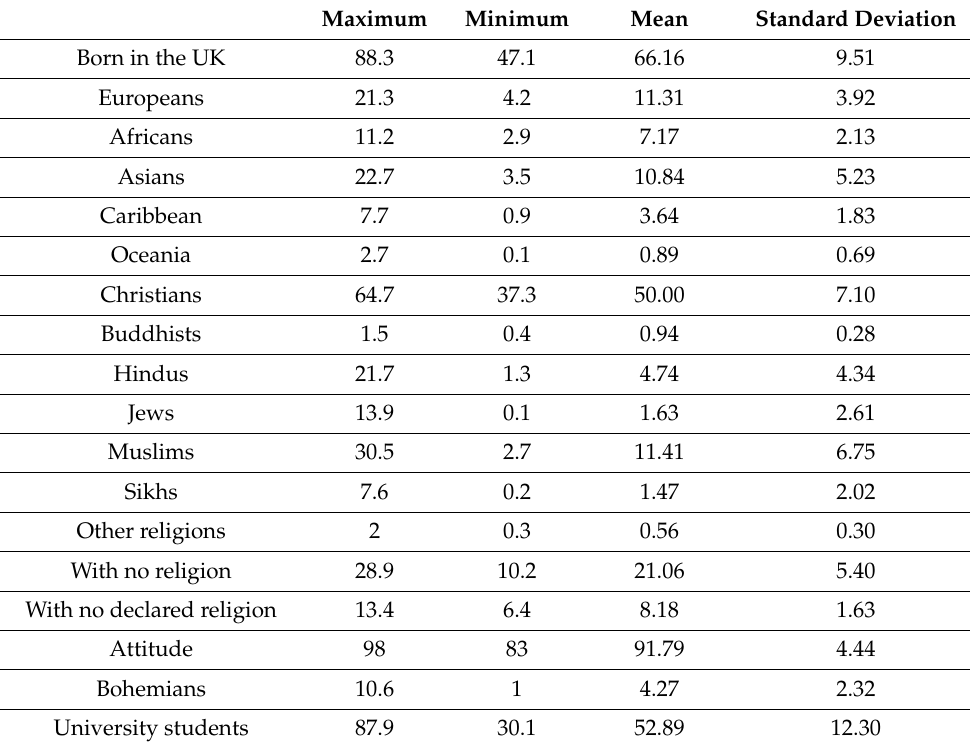
Table 4. Main statistical indicators of the variables